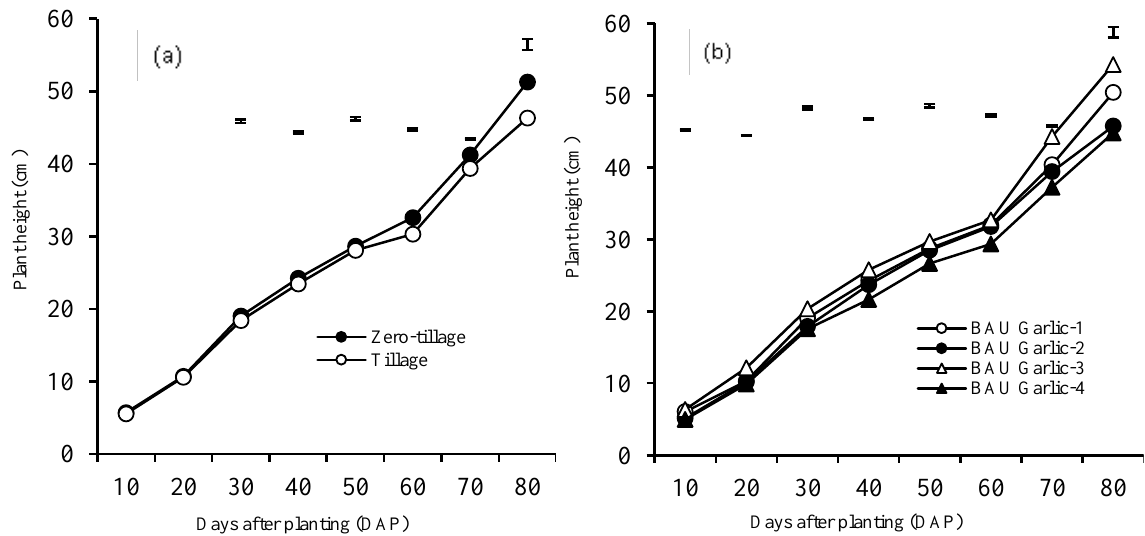
Figure 1. Effects of planting system (a) and variety (b) on plant height of garlic at different days after planting. Vertical bars indicate LSD at 1% level of significance.